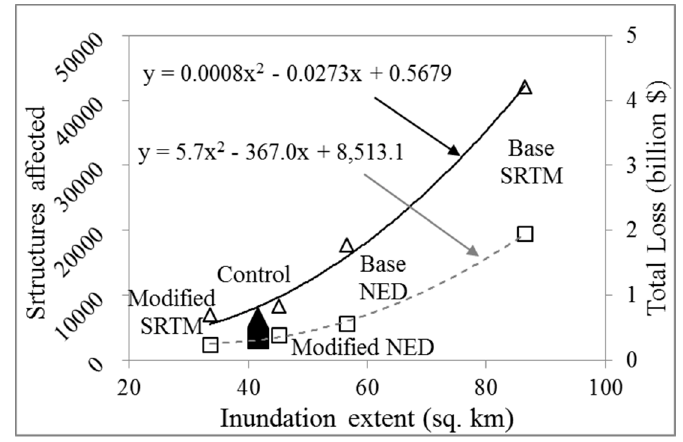
Figure 10. Simulated flood consequences versus inundation extent.